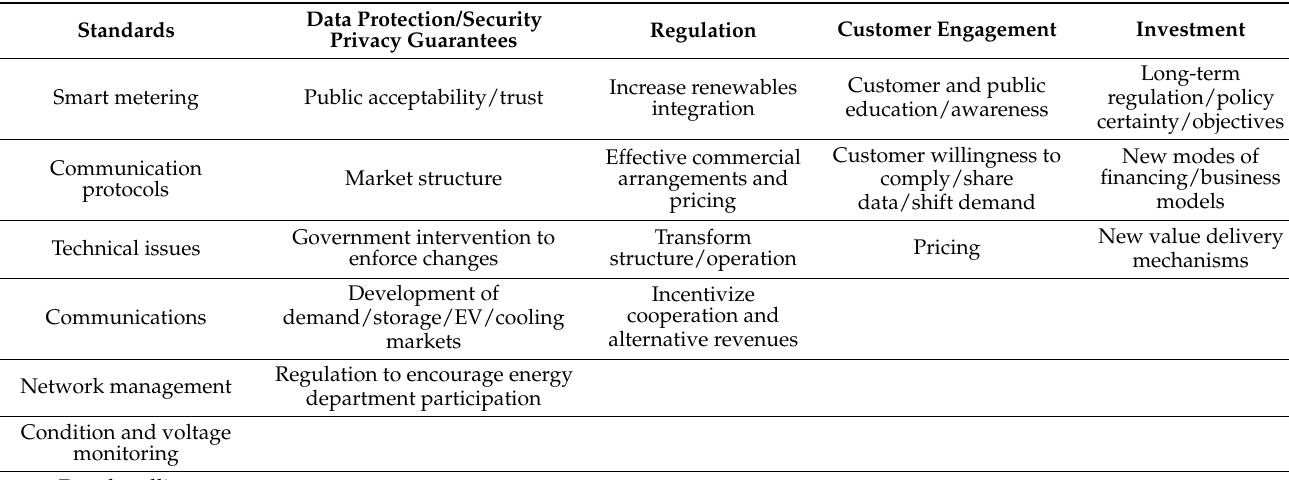
Table 5. Summary of essential responses for the factors that influence SGS